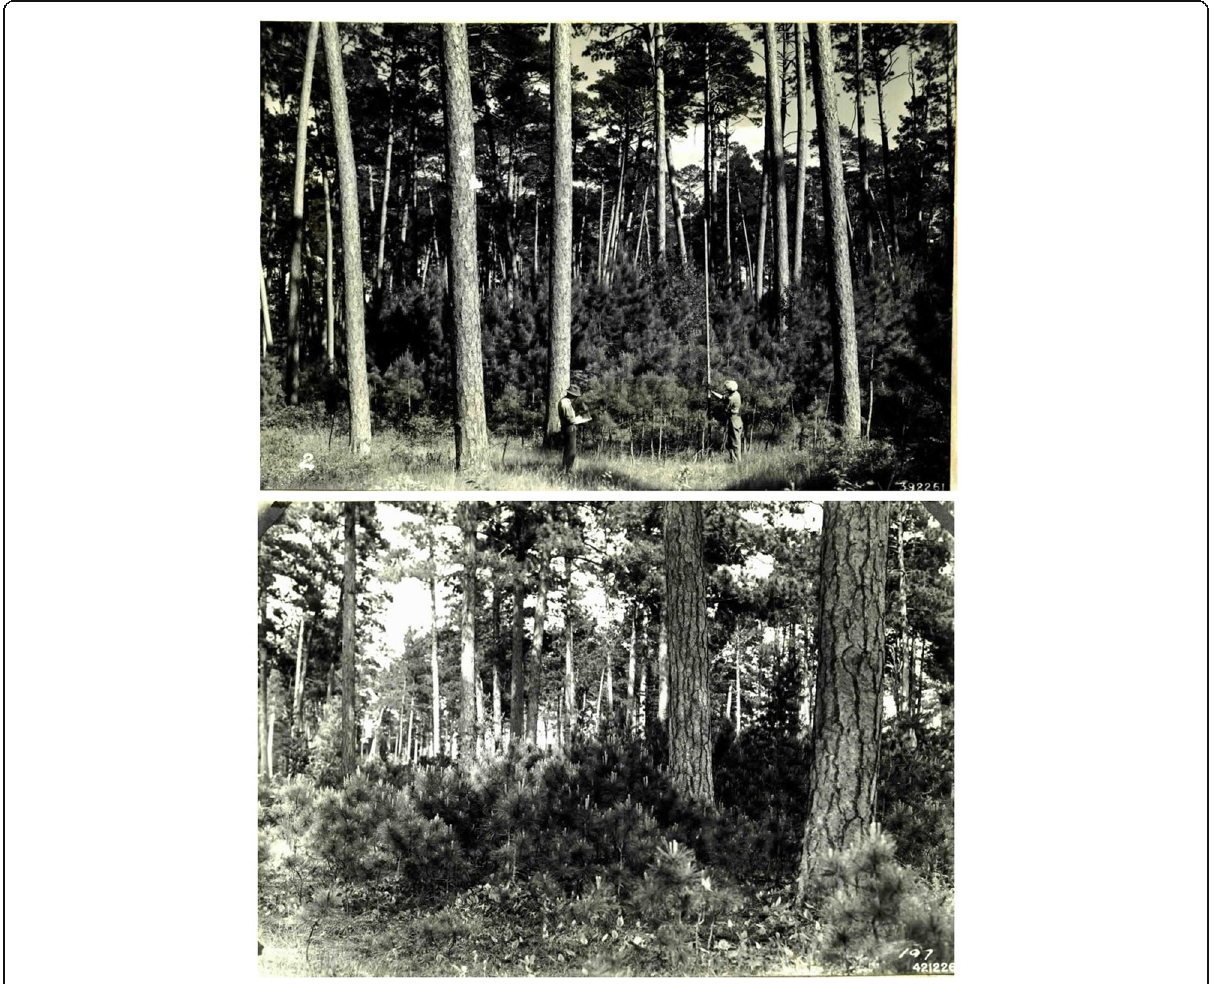
Fig. 1 Historical photo documentation of large gap regeneration and heterogeneous canopy structure in red pine-dominated ecosystems (colloquially referred to as Norway pine). The photos, taken in 1939, are from what is now the Chippewa National Forest, MN, USA. Top: